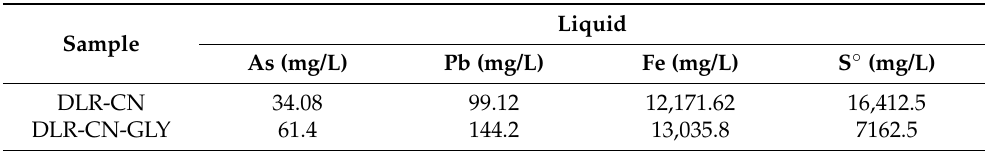
Table 4. Concentration of As, Pb, Fe, and S of the liquid samples obtained from the conventional and glycine-assisted cyanidation of the DLR without pretreatments.